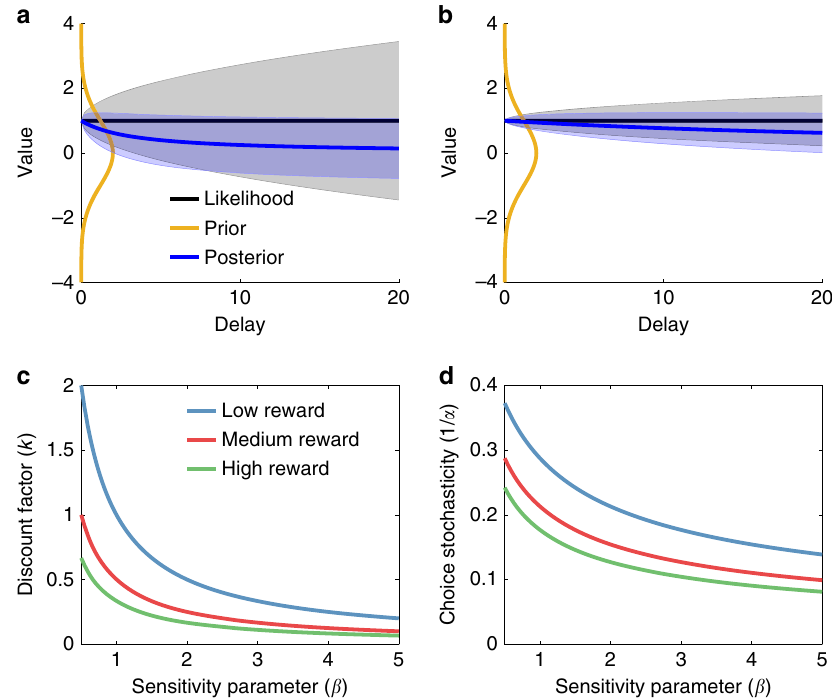
Fig. 1 Illustration of rational-discounting model. a Illustration of discounting as Bayesian inference. Mental simulation generates a noisy value signal ( s t = 1), which is combined with a prior distribution to form a posterior distribution over value. The black line denotes the true underlying value u , and the shaded region shows the standard deviation of the noise corrupting the value at each possible delay t (in arbitrary units). Similarly, the blue line is the posterior mean, and the shaded region is the posterior standard deviation. Because the standard deviation of s t (simulation noise) increases with delay, the posterior mean is pulled more strongly towards the prior mean for longer delays. b Same simulation as in a but with a smaller signal variance, demonstrating a reduction in discounting. c Discount factor under the rational inattention model as a function of the sensitivity parameter ( β ) and reward magnitude. d Choice stochasticity under the rational inattention model as a function of the sensitivity parameter ( β ) and reward